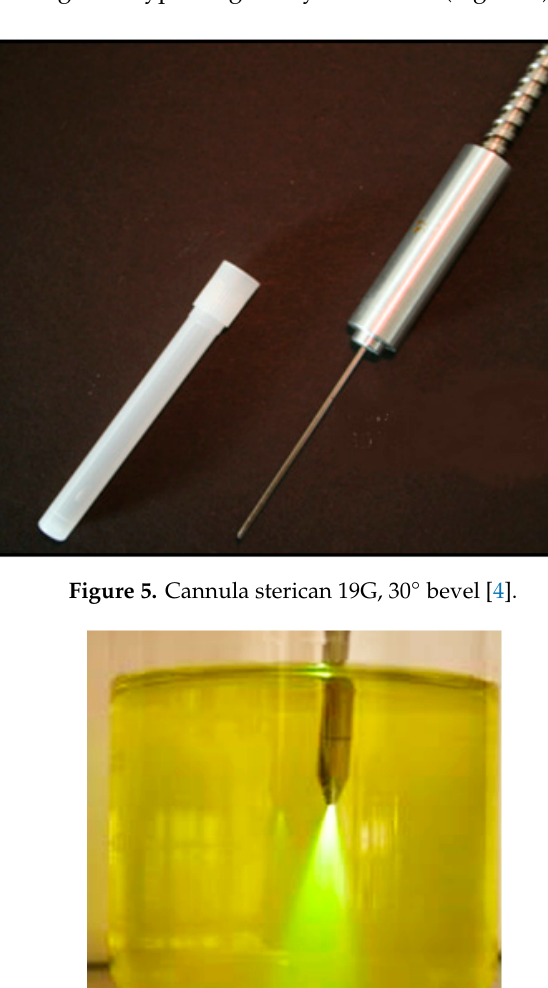
Figure 6. Tyndall effect, 10 ppm fluorescein sodium in water [4]. Figure 6. Tyndall e ff ect, 10 ppm fluorescein sodium in water